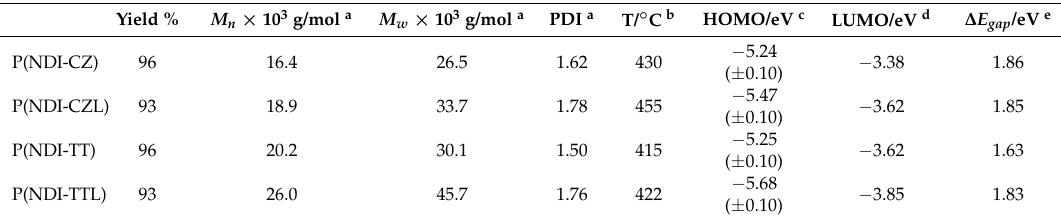
Figure 1. The SEC chromatograms of polymers. Table 1. Polymer properties and yields.